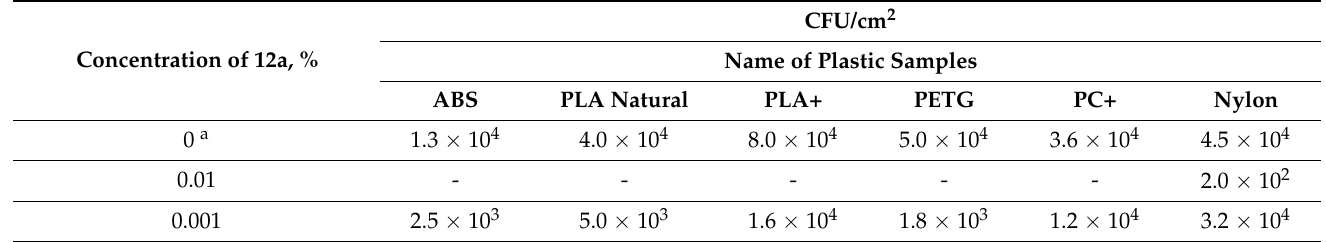
Table 4. Evaluation of bactericidal properties of a plastic sample (1 cm 2 ) after 24 h of incubation with 10 5 S. aureus 209 P .